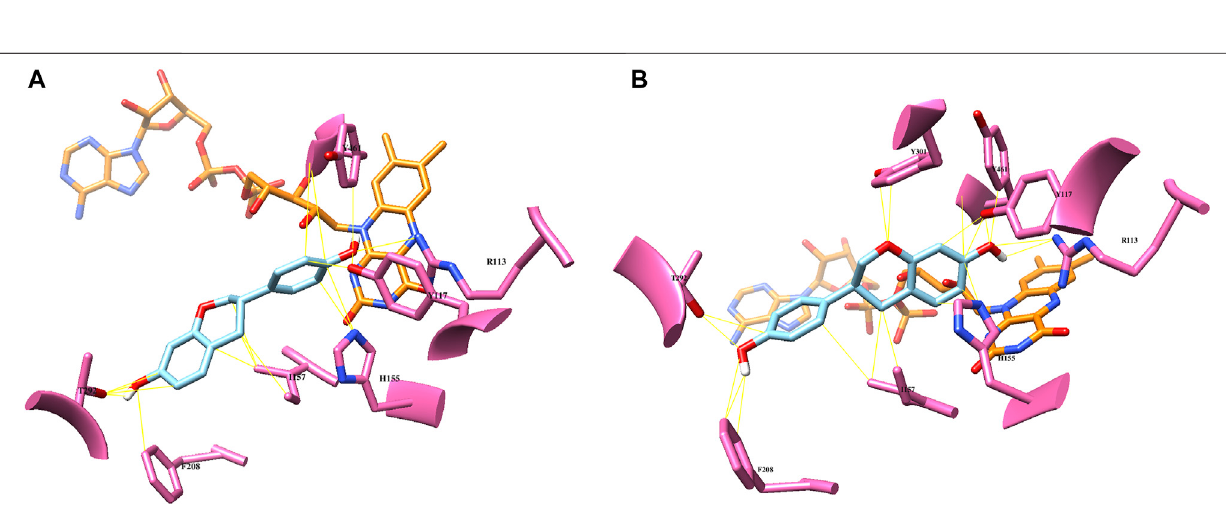
Frontiers in Bioengineering and Biotechnology |